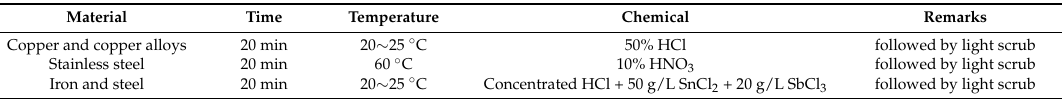
Table 4. Removal methods of corrosion products from